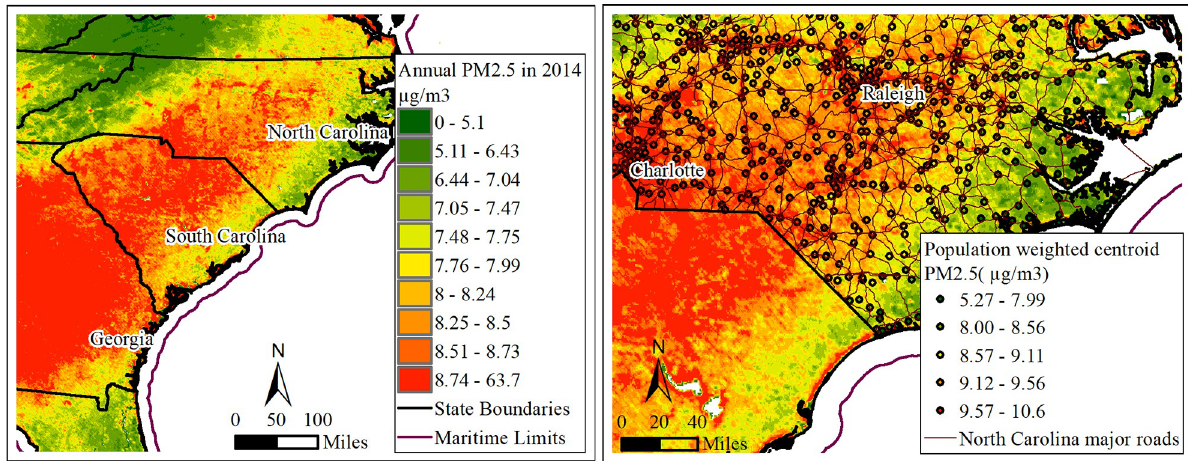
Fig 1. Annual concentrations of PM 2.5 ( μ g/m 3 ). The measures from the ground level monitors ( Fig 1A , on the left) and the measures recalculated for the population-weighted centroids of zip codes ( Fig 1B , on the right), North Carolina, 2014.